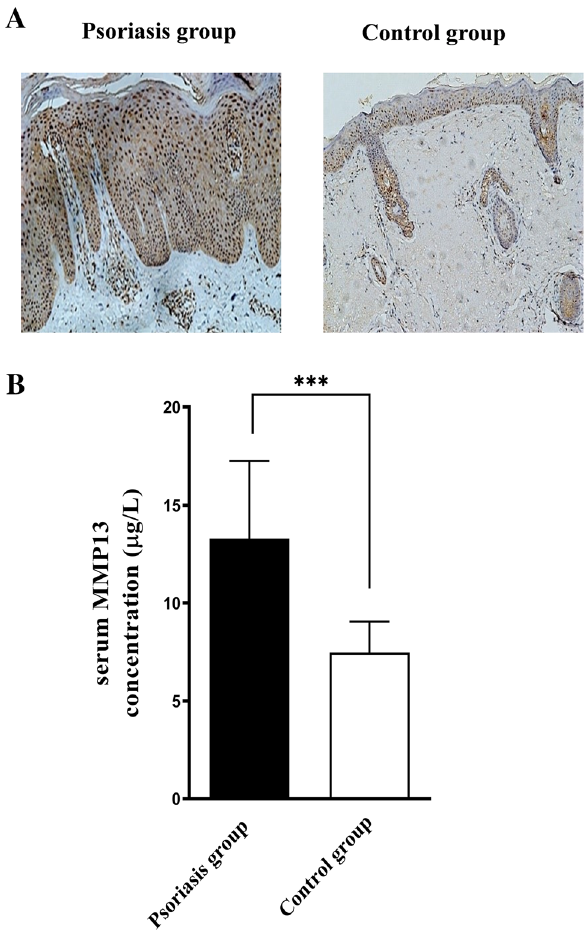
Figure 1. Expression of MMP13 in patients with psoriasis. ( A ) Immunostaining for MMP13 in psoriasis and normal skin tissues. Representative images of MMP13 staining are shown (×100). ( B ) Quantification of serum ∗ P MMP13 levels in patients with psoriasis and control subjects. < 0.05 relative to